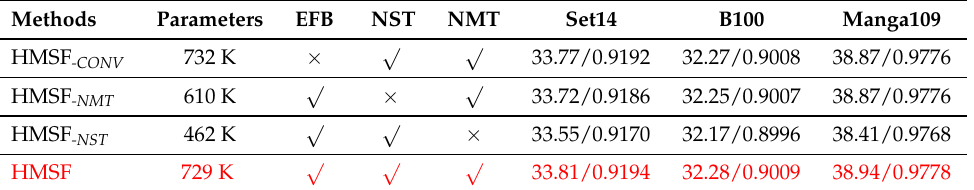
Table 4. The ablation experiment results of EFblock, local multi-scale learning and global multi-scale learning were evaluated on three common datasets of 2 × with PSNR/SSIM. Red text means the best performance.